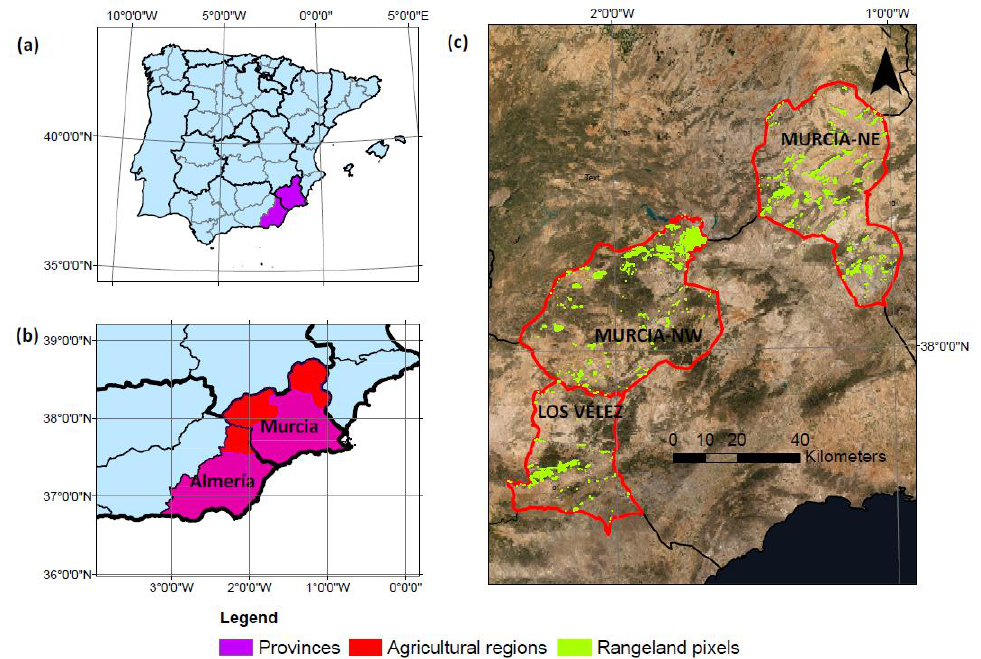
Figure 1. Location of the study area. ( a ) Selected Provinces. ( b ) Selected agricultural regions of Al- meria and Murcia. ( c ) Selected pixels in three agricultural regions of Almería and Murcia. Source basemap: Invierno 2020. Gobierno de España y Comunidad Autónoma de Murcia. CC-BY 4.0 2020. scne.es